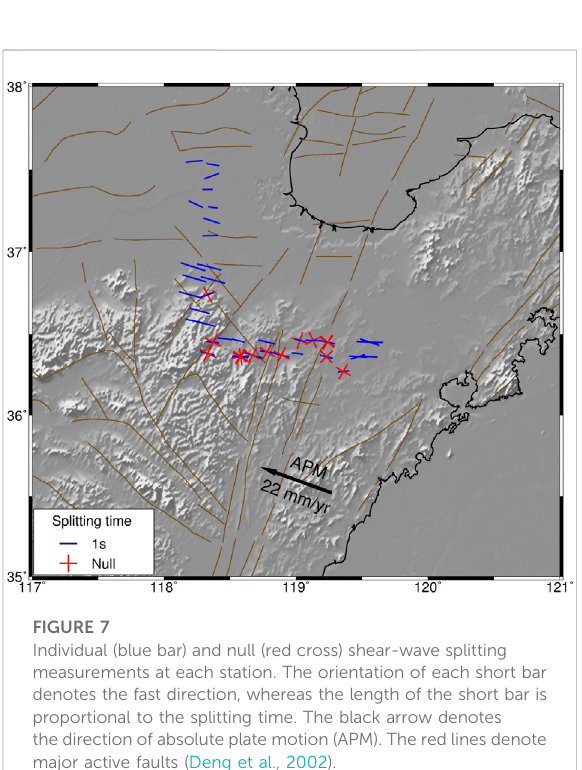
FIGURE 7 Individual (blue bar) and null (red cross) shear-wave splitting measurements at each station. The orientation of each short bar denotes the fast direction, whereas the length of the short bar is proportional to the splitting time. The black arrow denotes the direction of absolute plate motion (APM). The red lines denote major active faults (Deng et al., 2002).